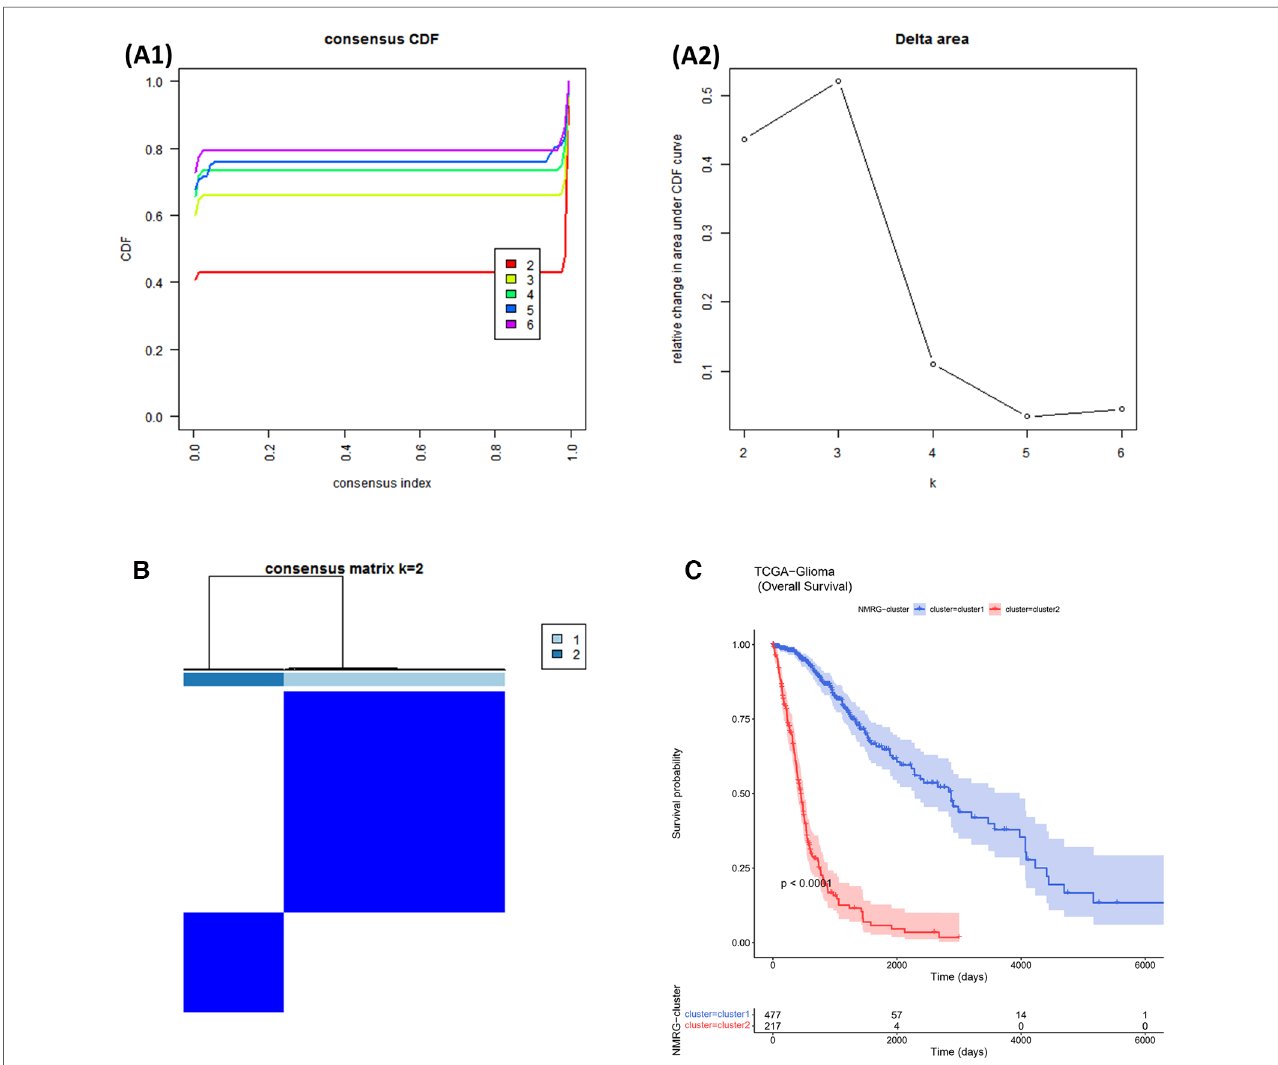
FIGURE 1 NMRGs classify glioma patients into different two subtypes. ( A1,A2 ) Cumulative Distribution Function (CDF) plot for consistent clustering ( B ) consistency clustering heat map. The colours indicate the ease of clustering. ( C ) Survival curves for cluster1 and